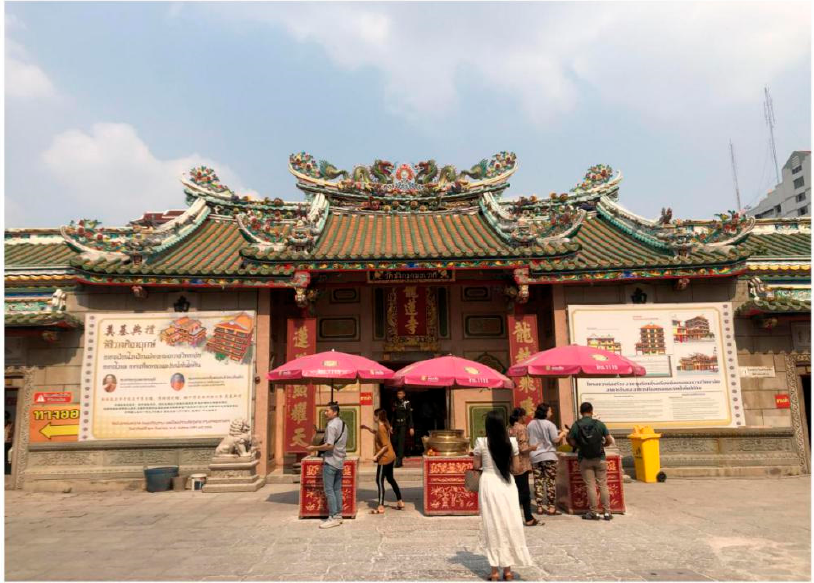
Figure 4. Representative images of Wat Mangkon Kamalawat sampled.